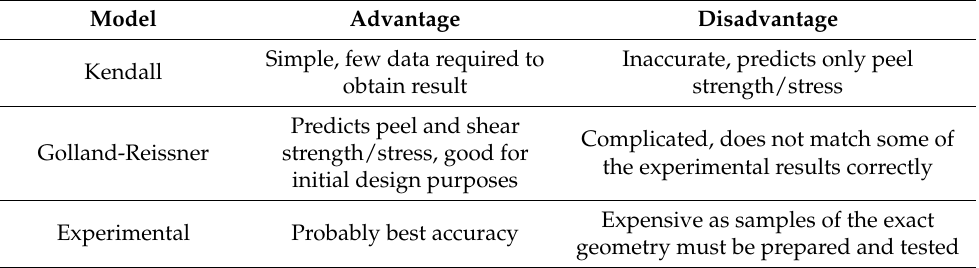
Table 3. Adhesion models comparison.